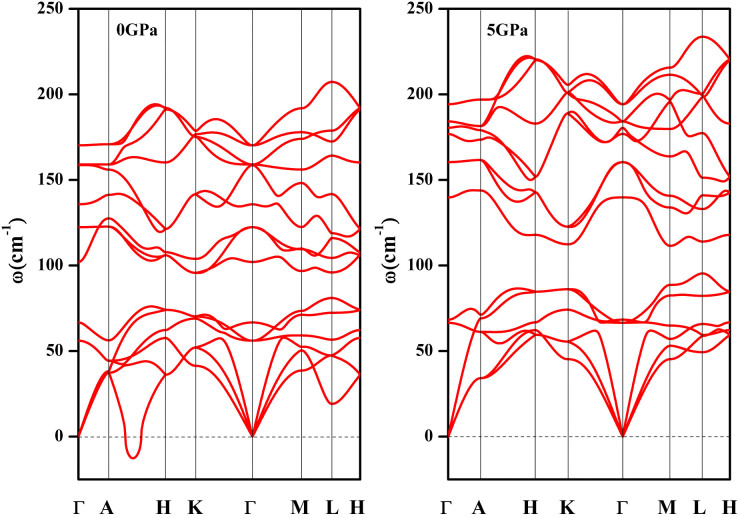
Phonon dispersion curves for the hP5-Ca3Bi2 at 0 GPa and 5 GPa.